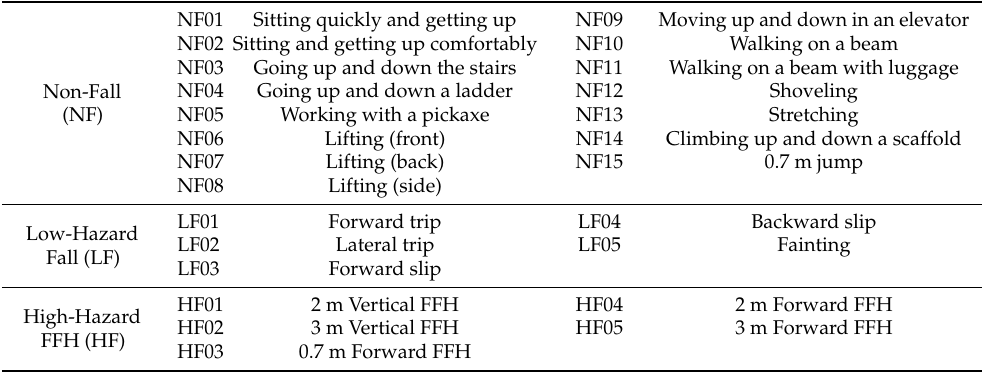
Table 1. Experimental movements.